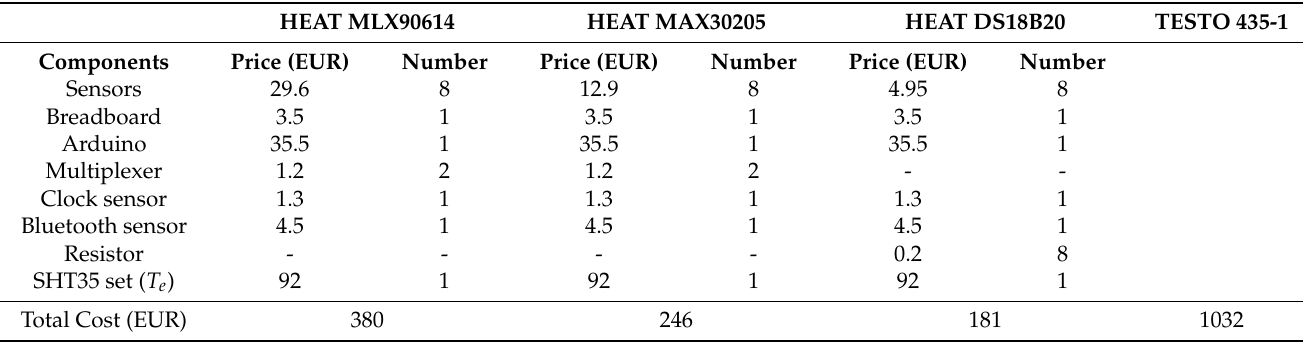
Figure 14. Cost reduction of the developed sensor compared with TESTO, as well as the differences of the individual kits and three HEATs. Table 3. Cost comparison between the three developed sensors with the commercial TESTO